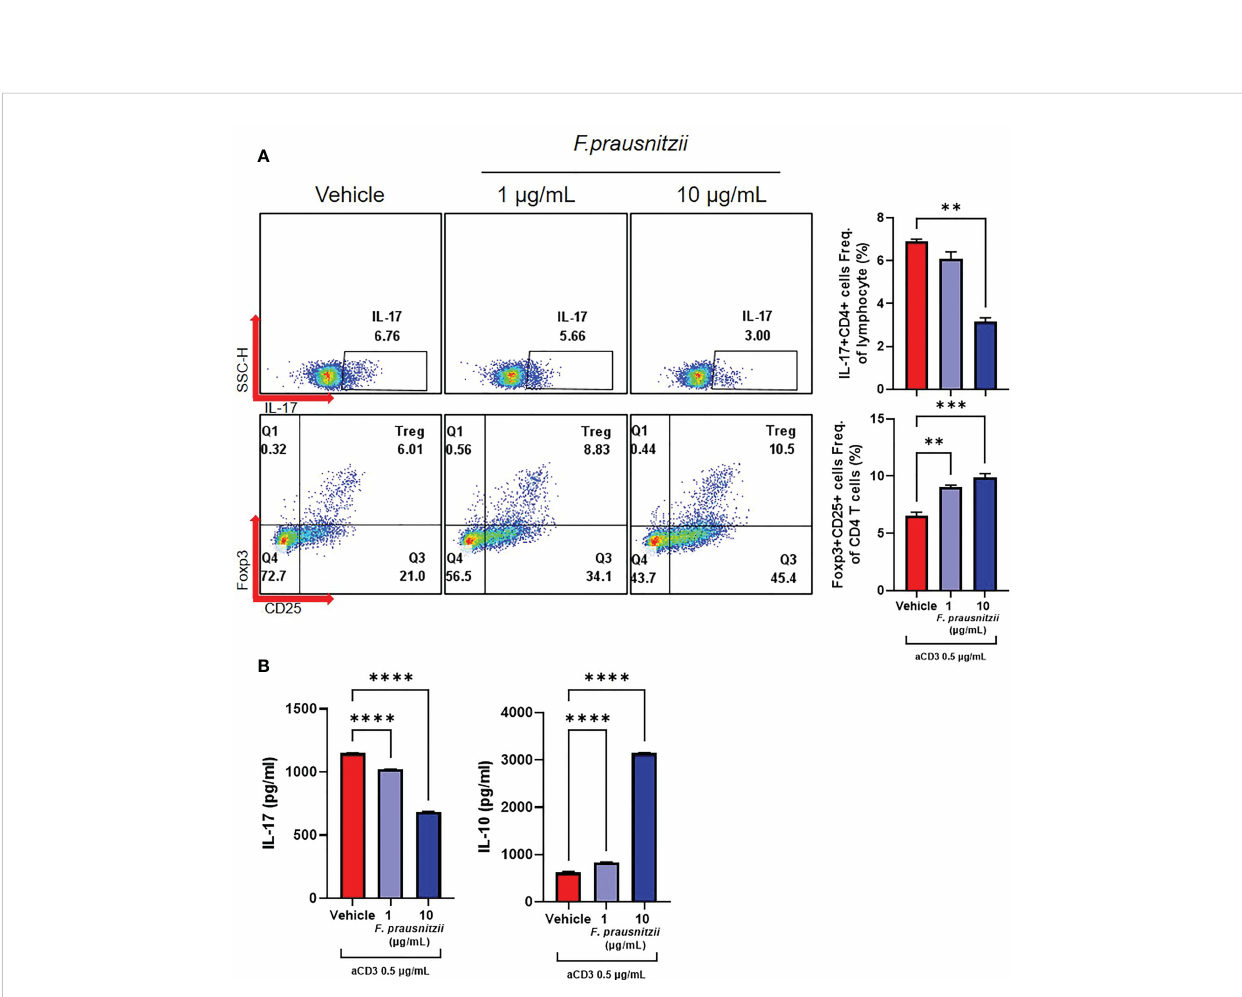
FIGURE 3 Effects of Faecalibacterium prausnitzii on the CD4 + T cell differentiation of axSpA patient-derived PBMCs. PBMCs (1 x 10 6 cells) were obtained from axSpA patients (N = 4). These were cultured with Faecalibacterium prausnitzii (1 or 10 m g/mL) with anti-CD3 Ab (0.5 m g/mL) for 72 h. (A) CD4 + IL-17A + T cell and CD4 + CD25 high Foxp3 + T cell differentiation was measured by fl ow cytometry (presented with representative fl ow cytometry image). (B) In culture media, the levels of IL-17A and IL-10 were measured by ELISA. ** P < 0.01, *** P < 0.001 and **** P <